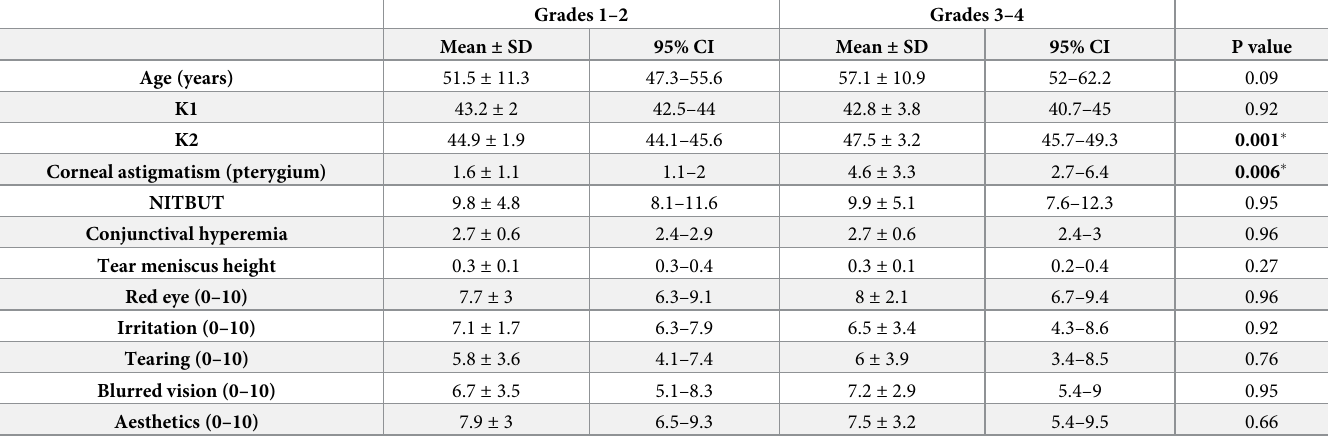
Table 2. Data distribution according to pterygium extension over the limbus (grades